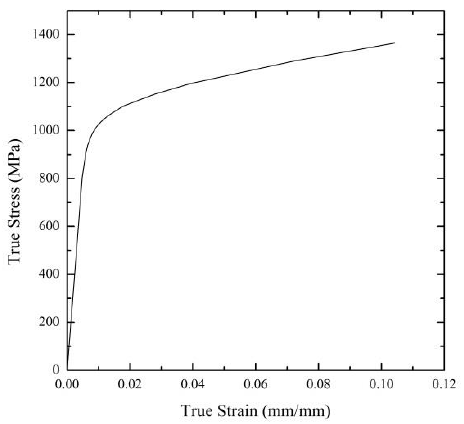
Figure 20. True stress – strain curve of the high-strength GH4169 alloy at 500 °C.